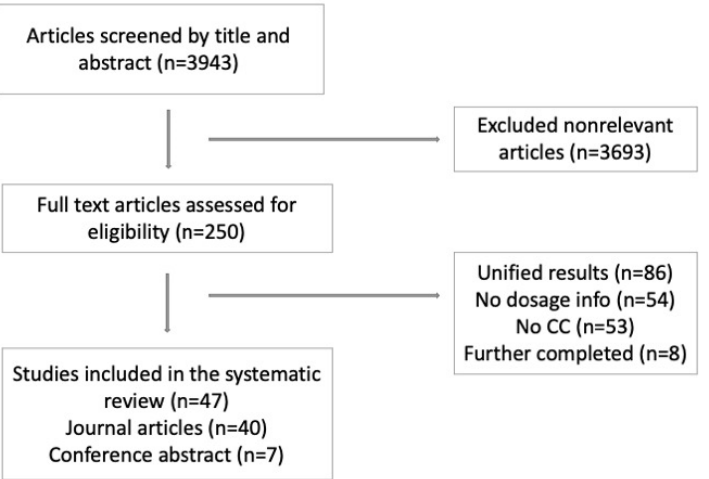
Figure 1. Identification of included papers. ICC: Intrahepatic Cholangiocarcinoma.